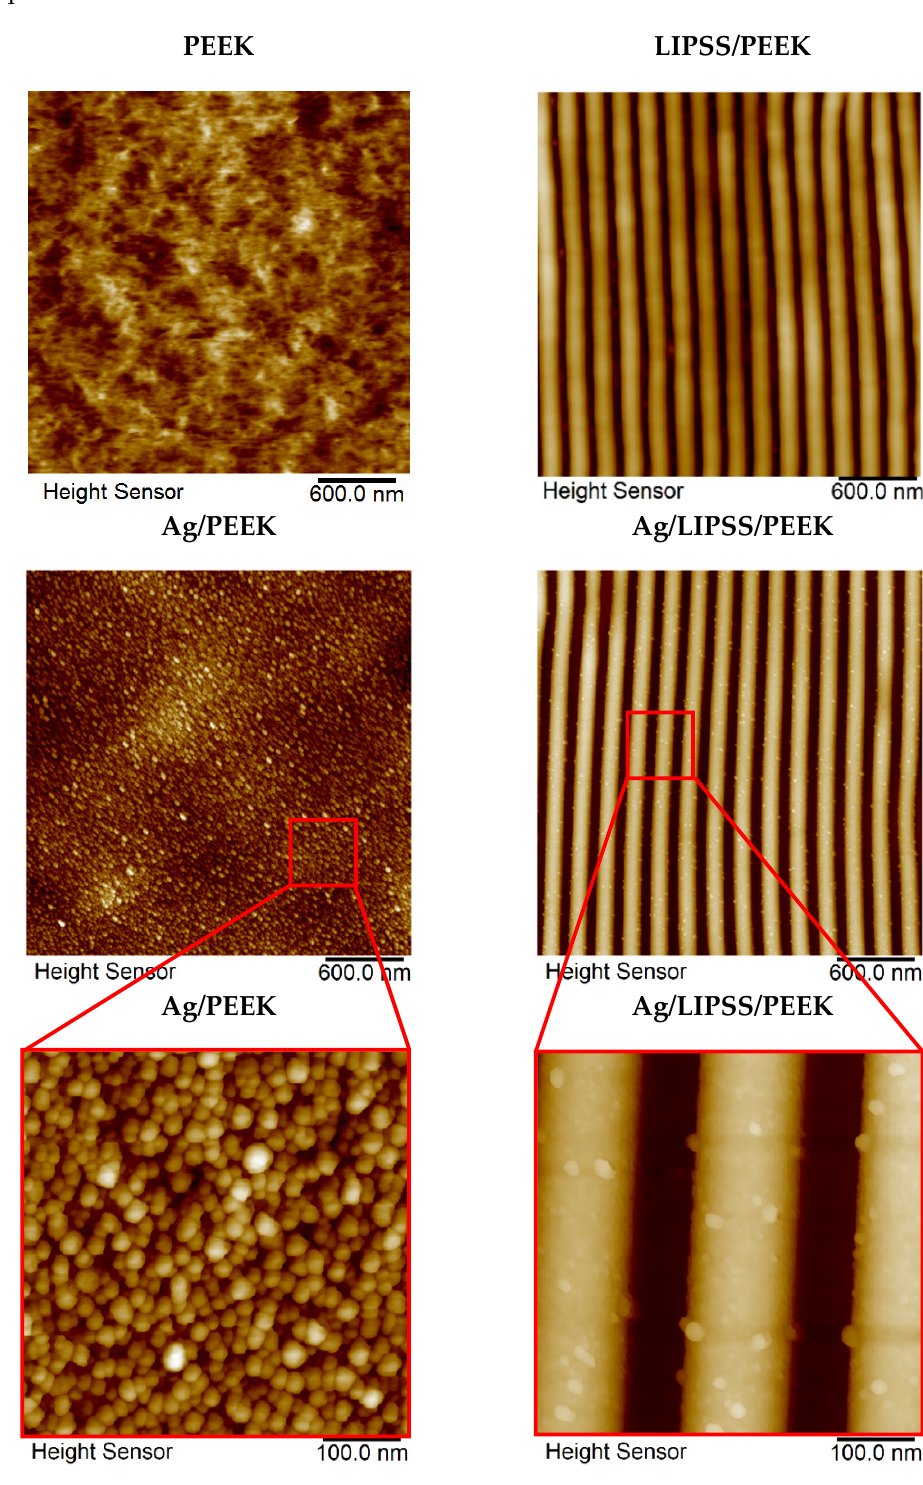
Figure 2. The 2D AFM images of as-received PEEK, PEEK with LIPSS structure (LIPSS/PEEK), AgNP-decorated PEEK (Ag/PEEK) and AgNP-decorated PEEK with LIPSS structure (Ag/LIPSS/PEEK) together with details of AgNP-decorated structures.